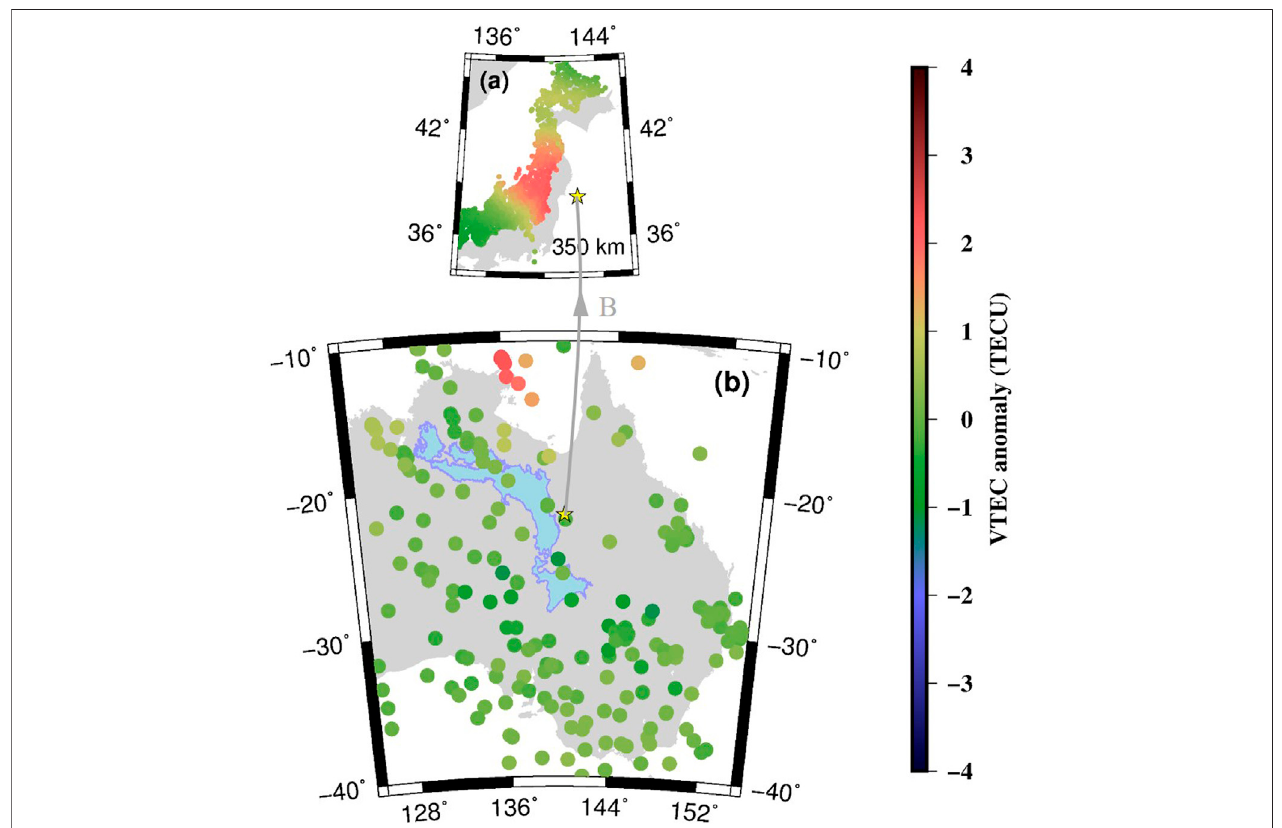
FIGURE7| DistributionofVTECanomaliesat05:45UT(1 minbeforetheTohoku-okiearthquake)on11March2011drawnusingGPSPRN02,05,09,12,25,and 29inAustralia (B) ,andusingPRN15inJapan (A) .Thelightbluemapin (B) showsthegeomagneticconjugateimageoftheJapaneseIslands.Theyellowstarsrepresent